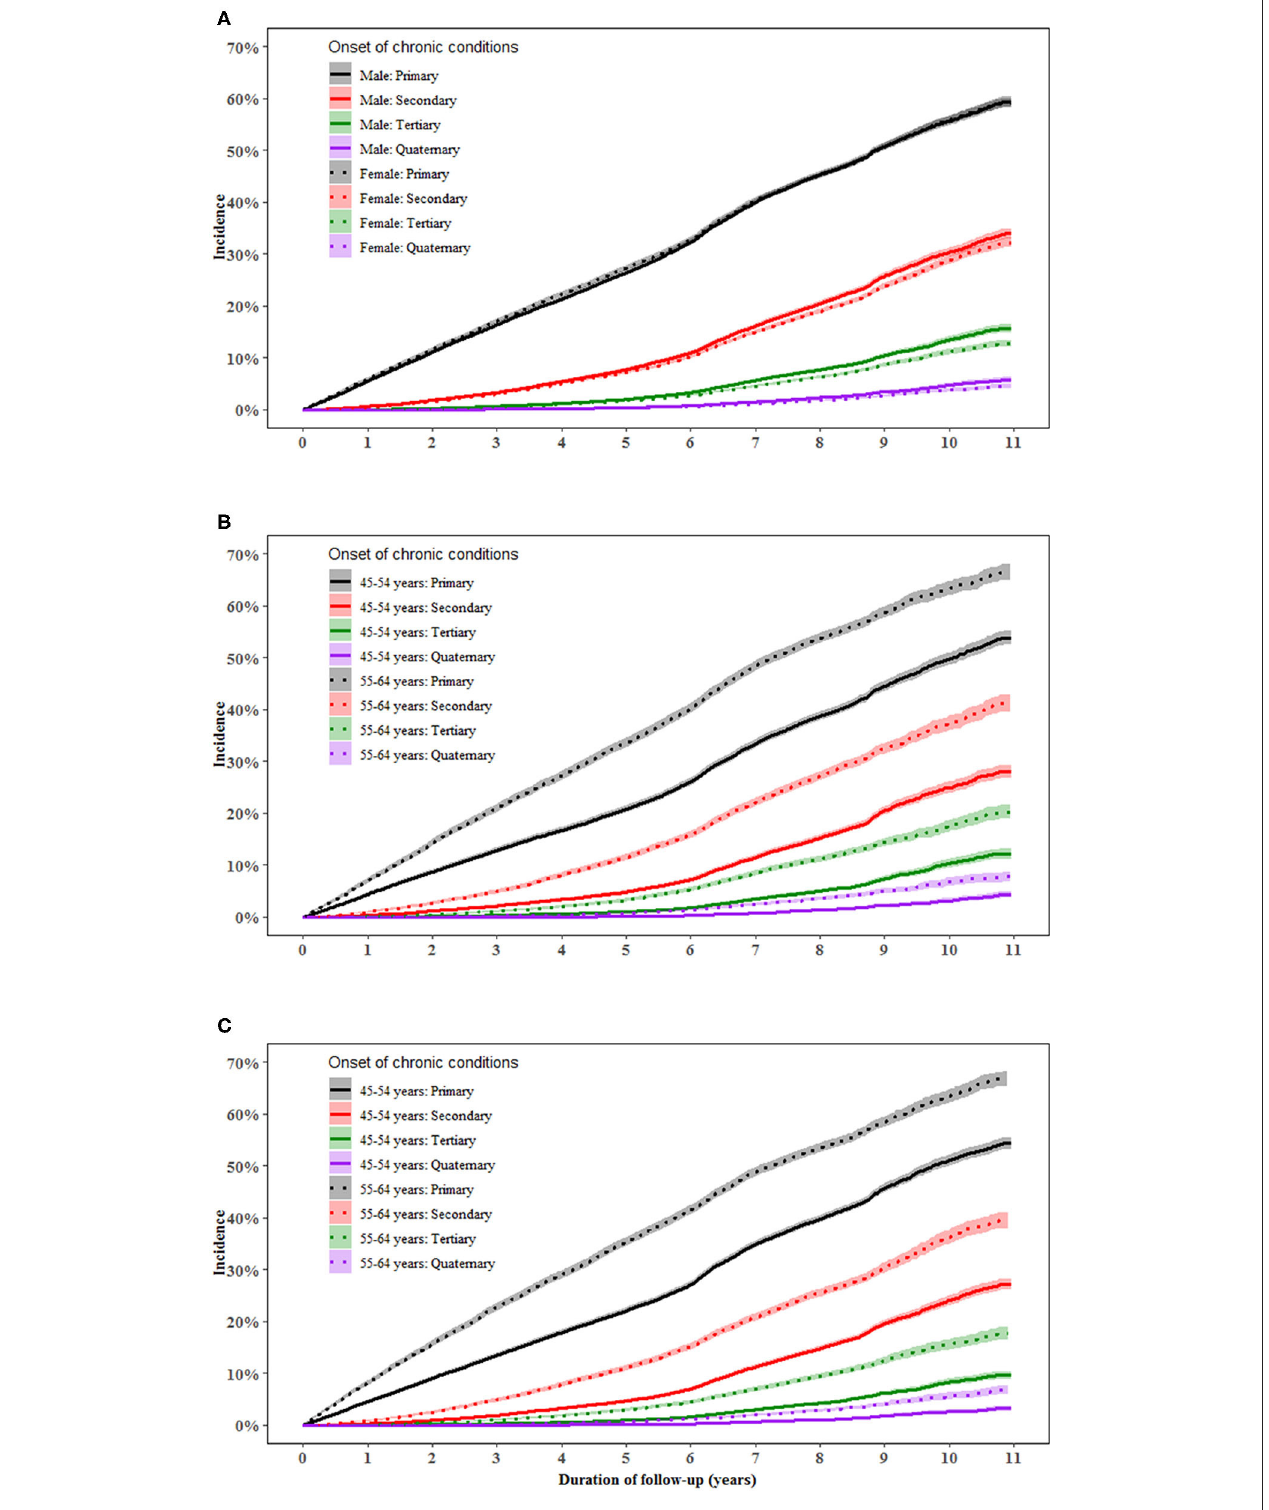
FIGURE 1 | Incidence of a primary, secondary, tertiary, and quaternary chronic condition in middle-aged men and women. (A–C) show the incidence of primary, secondary, tertiary, and quaternary chronic conditions in total population, men and women, respectively. Proportional Cox regression models were used to compare the incidence of multimorbidity between genders and between age groups after adjustment for the country of birth, income, education, BMI, and health insurance. Gender and age were mutually adjusted for.